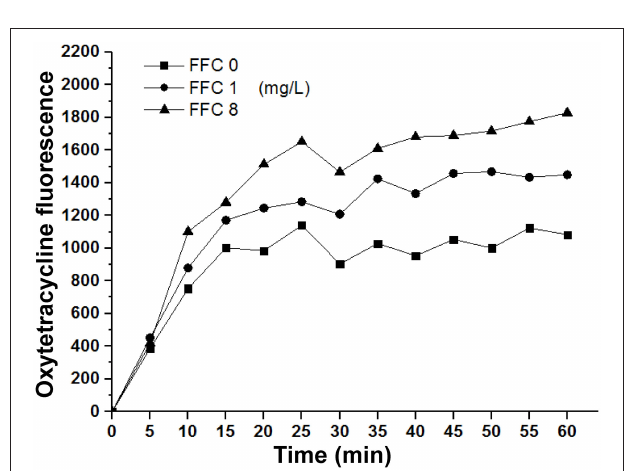
FIGURE 5 | Florfenicol (FFC) enhances the uptake of oxytetracycline in P. aeruginosa . Concentration of oxytetracycline was 128 mg/L, and FFC concentration was 0, 1, and 8 mg/L. Averages of triplicate experiments are shown.